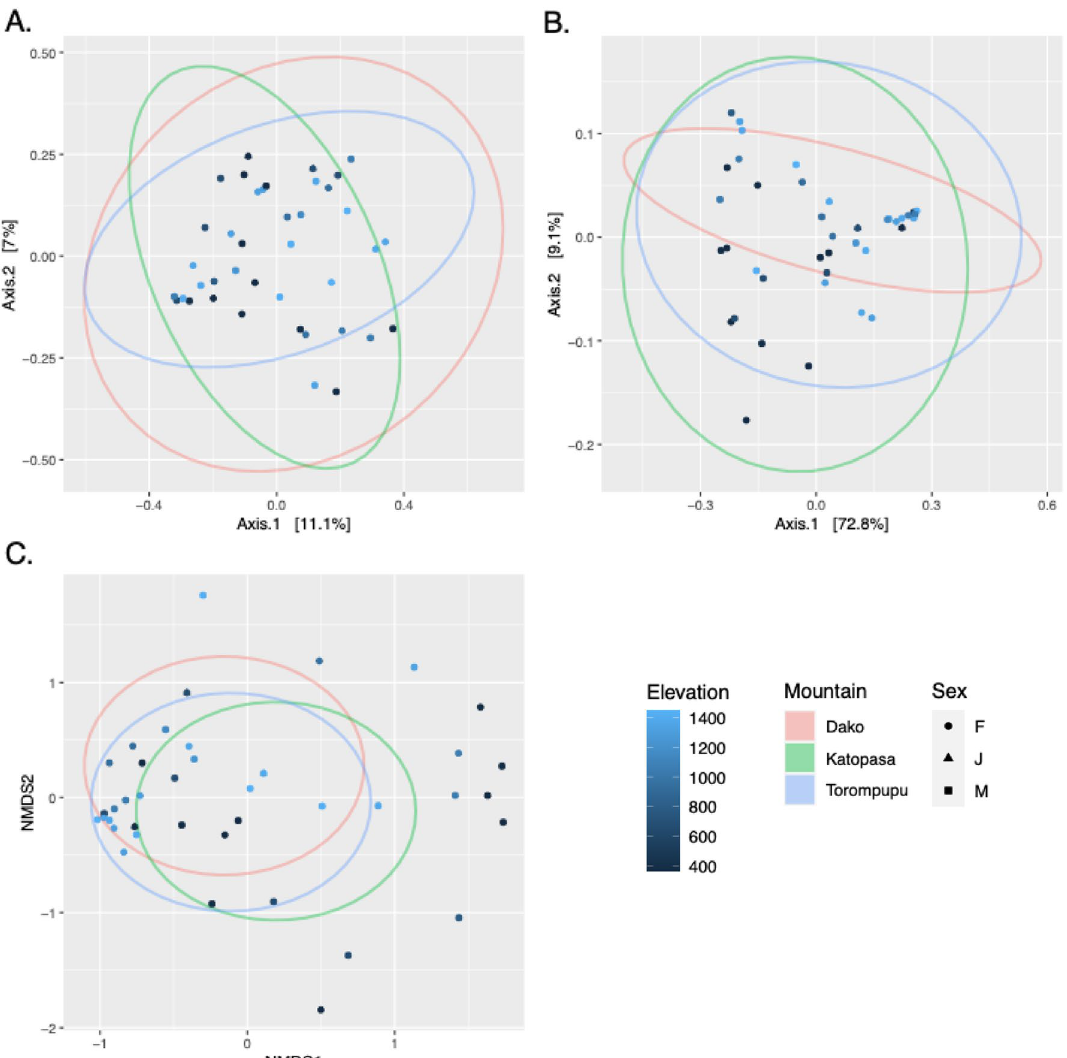
Fig. 4 Beta-diversity PCoA plots using unweighted Unifrac ( A ), weighted Unifrac ( B ), and NDMS ( C ) ordinations. Stress value for the NDMS was 0.190. Individuals are represented by a point shaped by sex and colored by elevation. Variations by mountain are represented by ordination